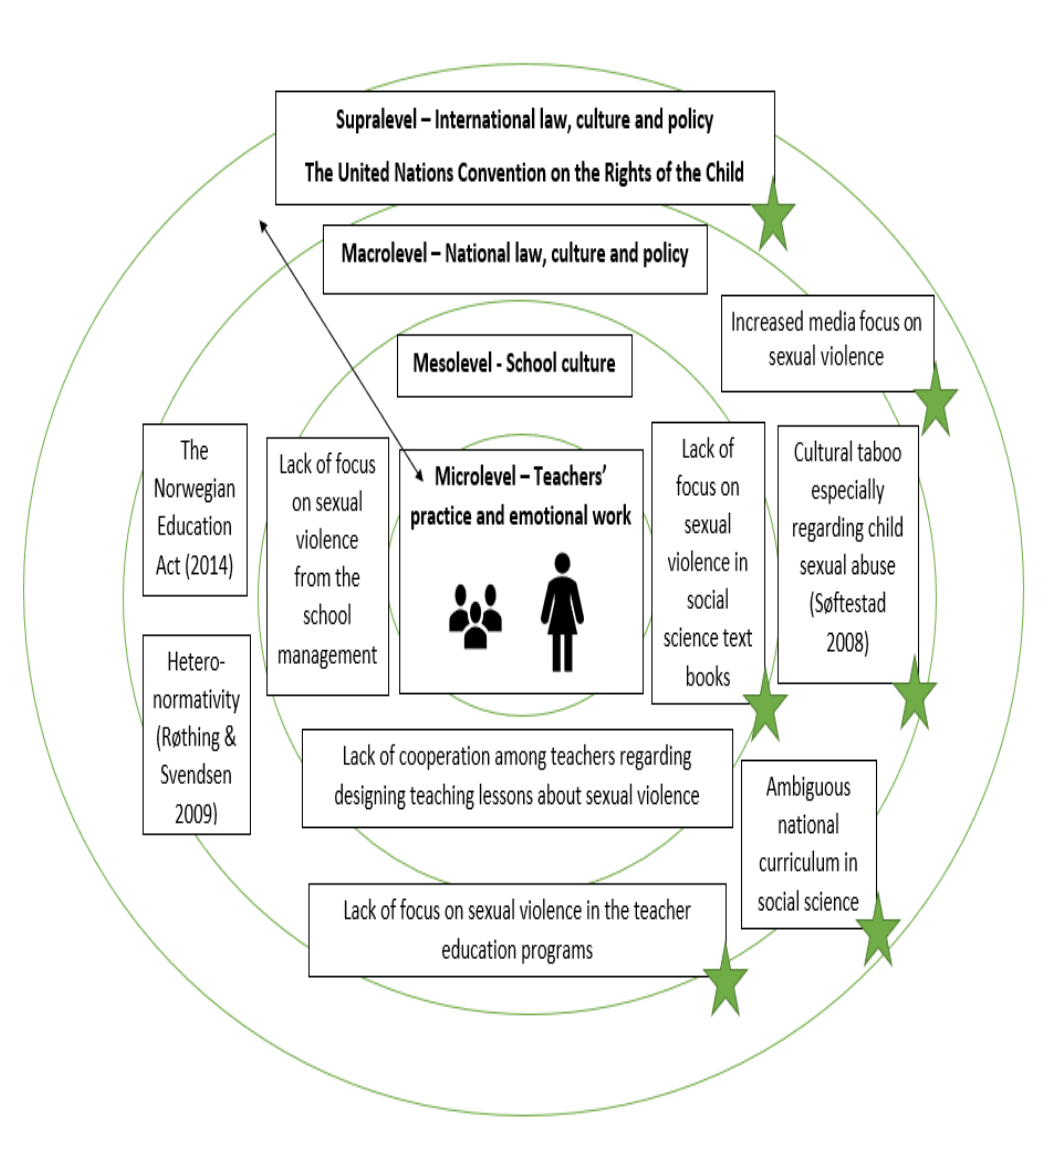
Figure 1: Structural and relational factors influencing teaching practice in the classroom. (The stars indicate the analytical foci of this article. The model is based on empirical data collected by the author, 2018. It is inspired by Uri Bronfenbrenner